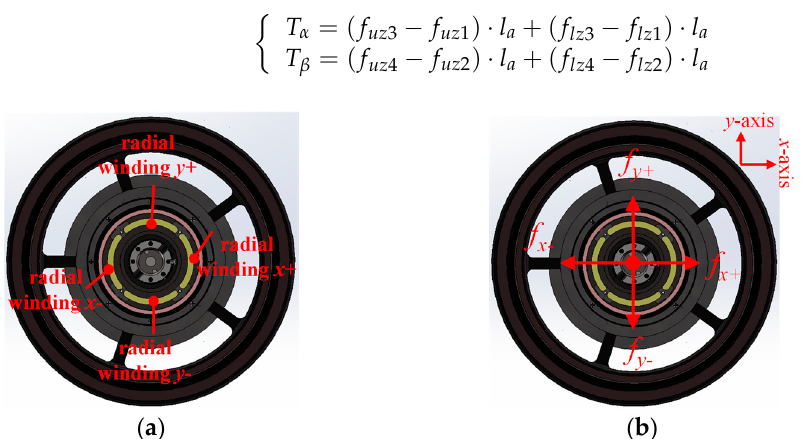
Figure 2. The structure and force models of the 2 − DoF radial AMB. ( a ) The top view of the 2 − DoF radial AMB; ( b ) the force distributions of the 2 − DoF radial AMB.